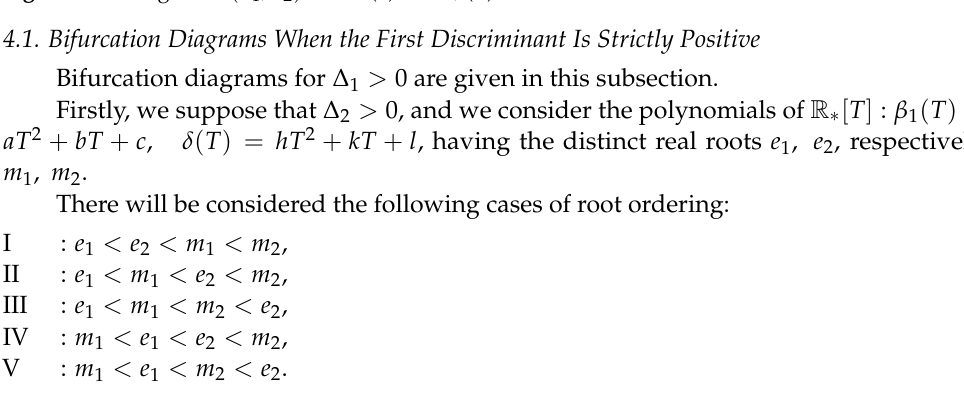
Figure 1. The sign of ∆ ( α 1 , α 2 ) when ( a ) a > 0; ( b ) a <